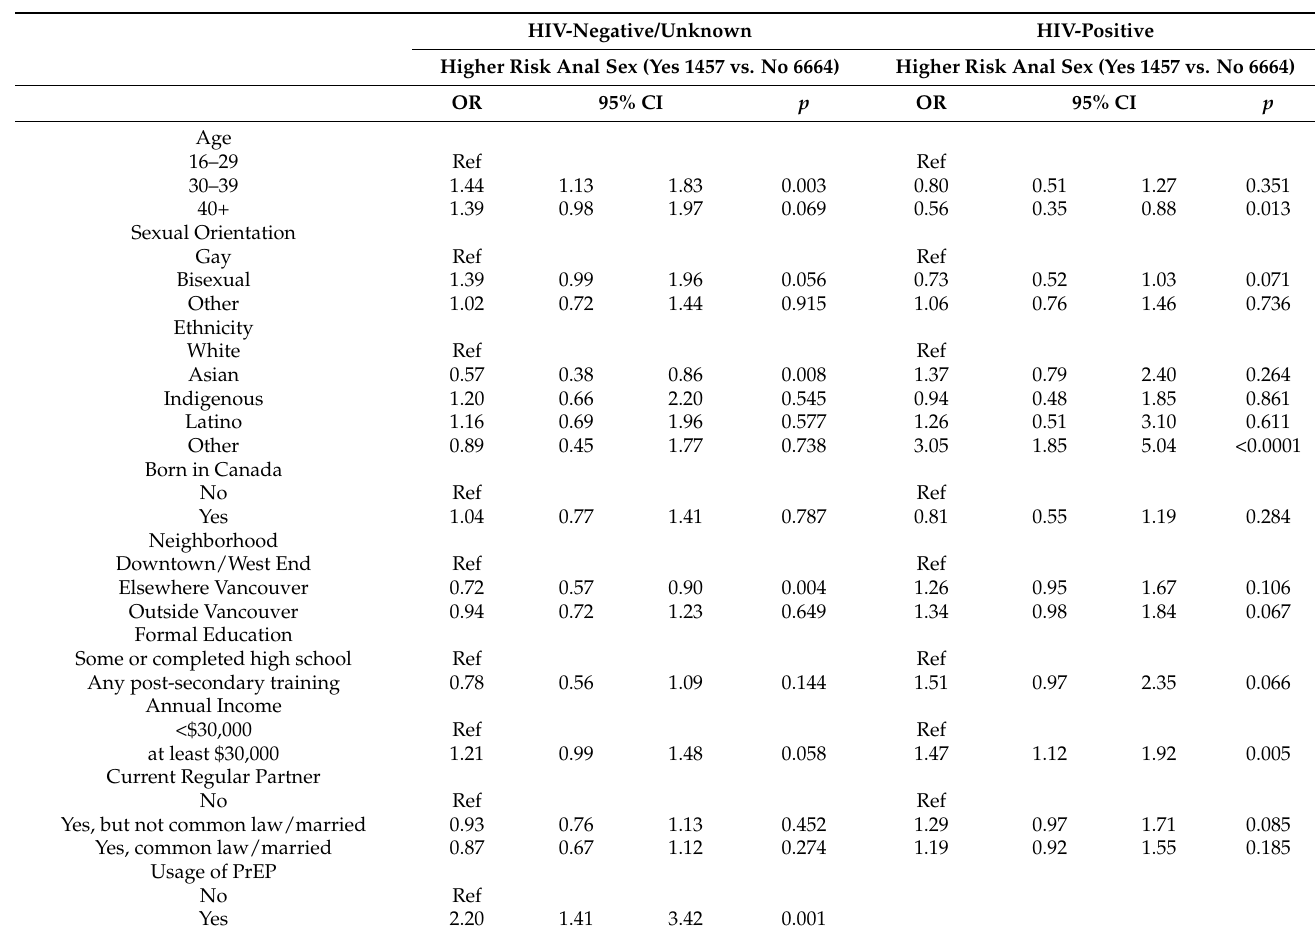
Table 2. Univariable generalized estimating equations assessing higher risk anal sex among gbMSM in Metro Vancouver, 2012–2017.